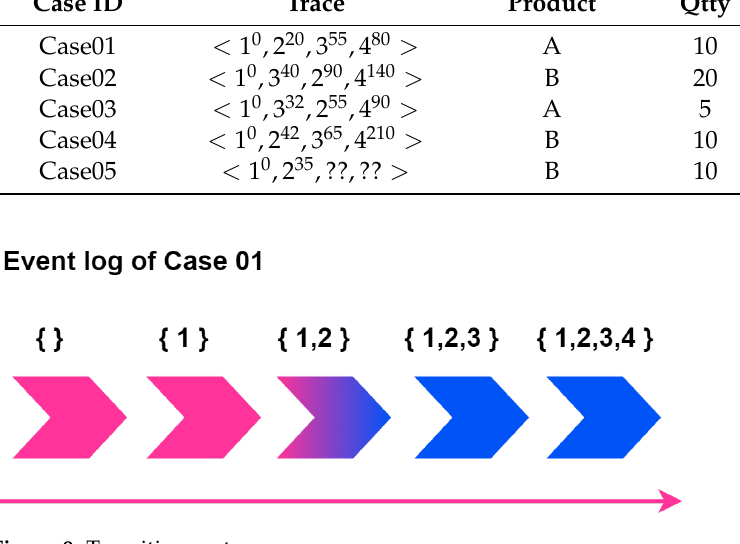
Figure 9. Transition